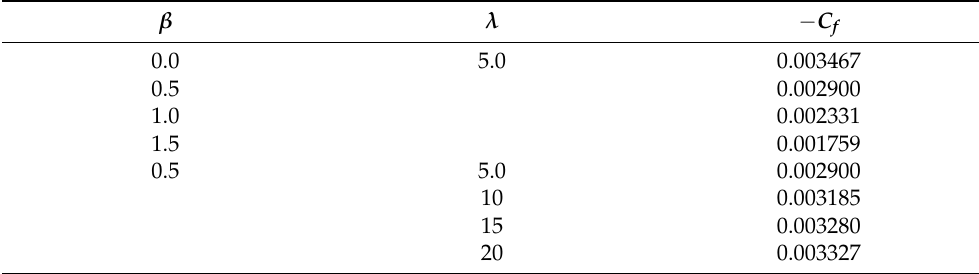
Table 3. Behavior of skin friction coefficient for Al 2 O 3 -Cu/H 2 Oagainst several